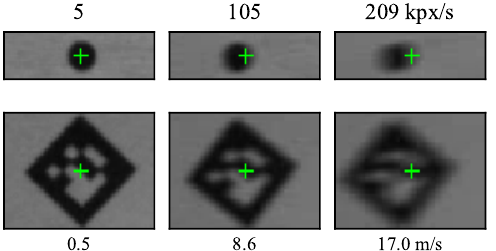
Figure 6. Sample ATIS ( top ) and DVS240 ( bottom ) event images of the black rotating dot moving left to right on white background at four different speeds (horizontal axis) and four different sensor illuminance levels (vertical axis). All images are cropped to 95 × 15 pixels from the original sensor plane with 200 events. Positive polarity events are white, negative black, and the background is grey. The green crosses indicate the ground truth median coordinates of the negative polarity events.